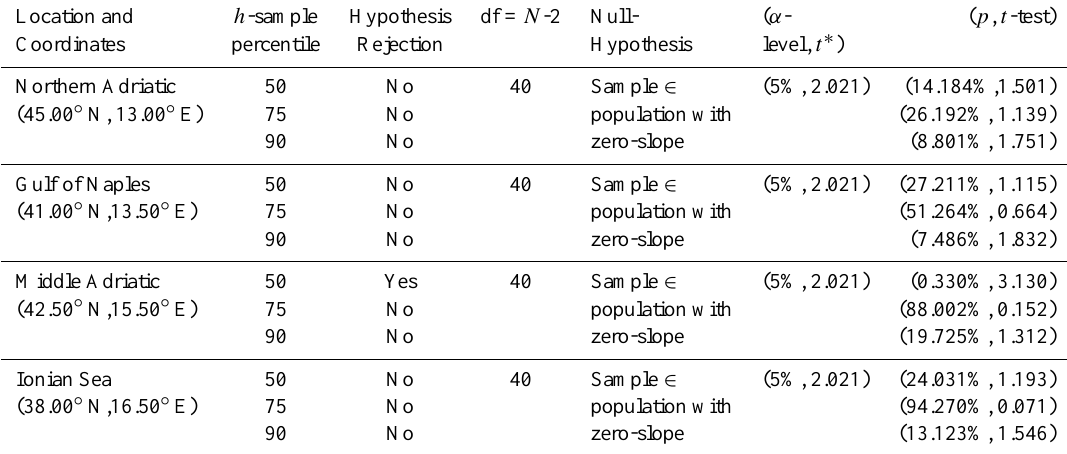
Table 3. Results of three tests of significance at the 5% α -level and based on Student’s t distributions with N -2 degrees of freedom (df) for four different geographical sites. The null-hypothesis of zero-slope refers to the trends of the annual H s durations over the 50th, 75th and 90th